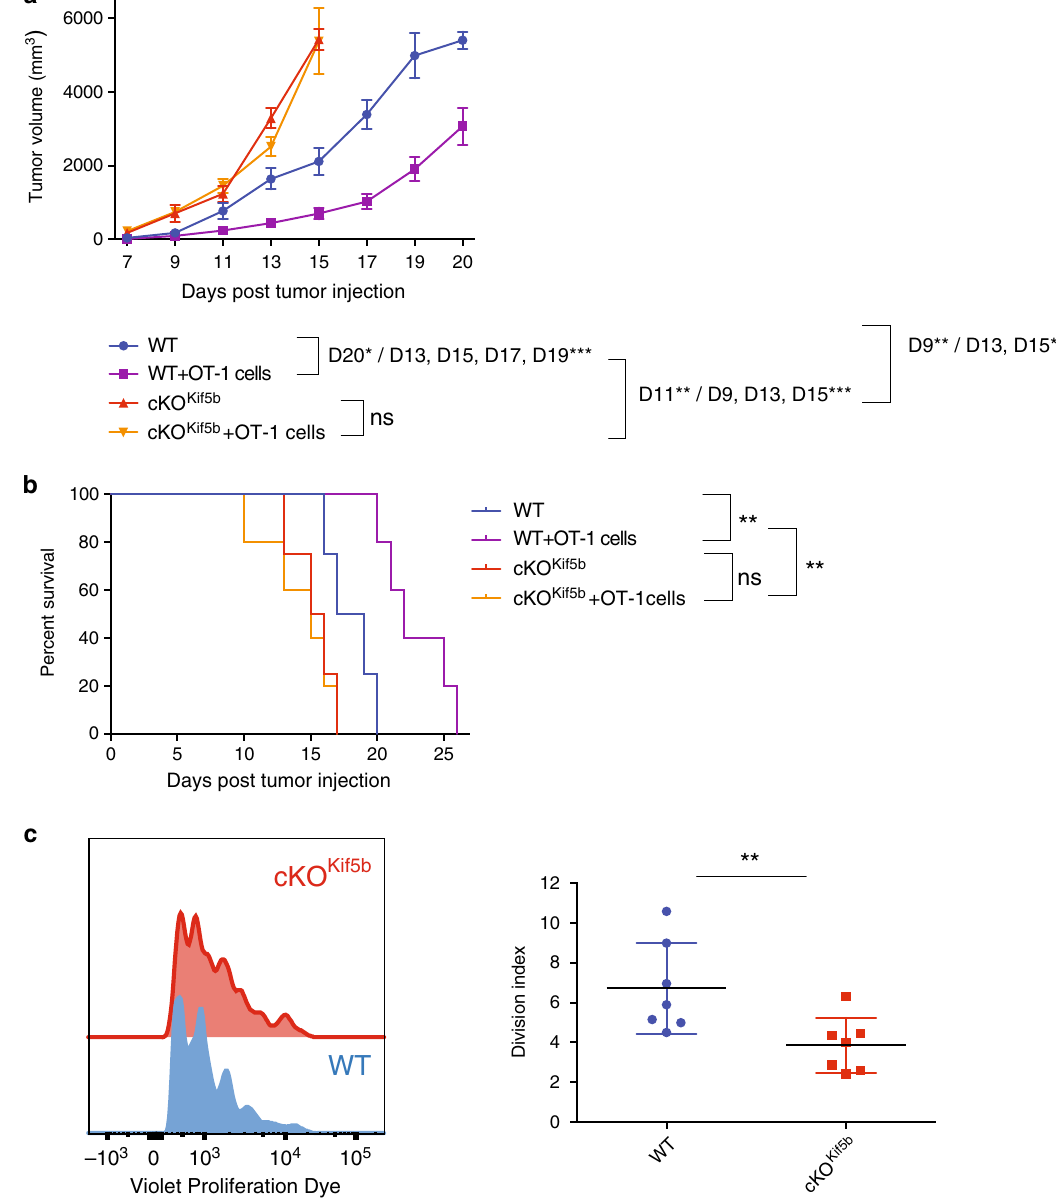
Fig. 2 cKO kif5b mice exhibit an impaired tumour response. a Tumour growth curves for WT (blue line) or cKO Kif5b (orange line) mice injected subcutaneously with B16-OVA cells and adoptively transferred with OT-I T cells (WT purple line, cKO Kif5b yellow line). Tumour growth was monitored daily, and non-survival was de fi ned as ulceration of the tumour or a mean tumour diameter of 15 mm. The data are quoted as the mean ± SEM from two independent experiments (WT, WT OT1, cKO Kif5b n = 10 mice per group, cKO Kif5b OT1 n = 9 mice). Statistical signi fi cance was determined by the two- way ANOVA and Sidak test ’ s correction for multiple comparison. * P < 0.05; ** P < 0.005; *** P < 0.0001. b Survival curves for WT or cKO Kif5b mice, treated as in a . Statistical signi fi cance was determined by the log-rank test and by the Gehan – Breslow – Wilcoxon test. * P < 0.05; ** P < 0.005. c Mice were injected with Violet-labelled transgenic OT-I T cells and primed 1 day later with CD11c/P3UOVA (WT blue line or circles, cKO Kif5b red line or circles; WT mice n = 7, cKO Kif5b mice n = 7). The left panel shows representative pro fi les gated on CD8 + , TCR V α 2 + cells. Statistical analysis of the division index is shown in the right panel: ** P < 0.005 in a two-tailed unpaired Student ’ s t test. Graph shows mean ±